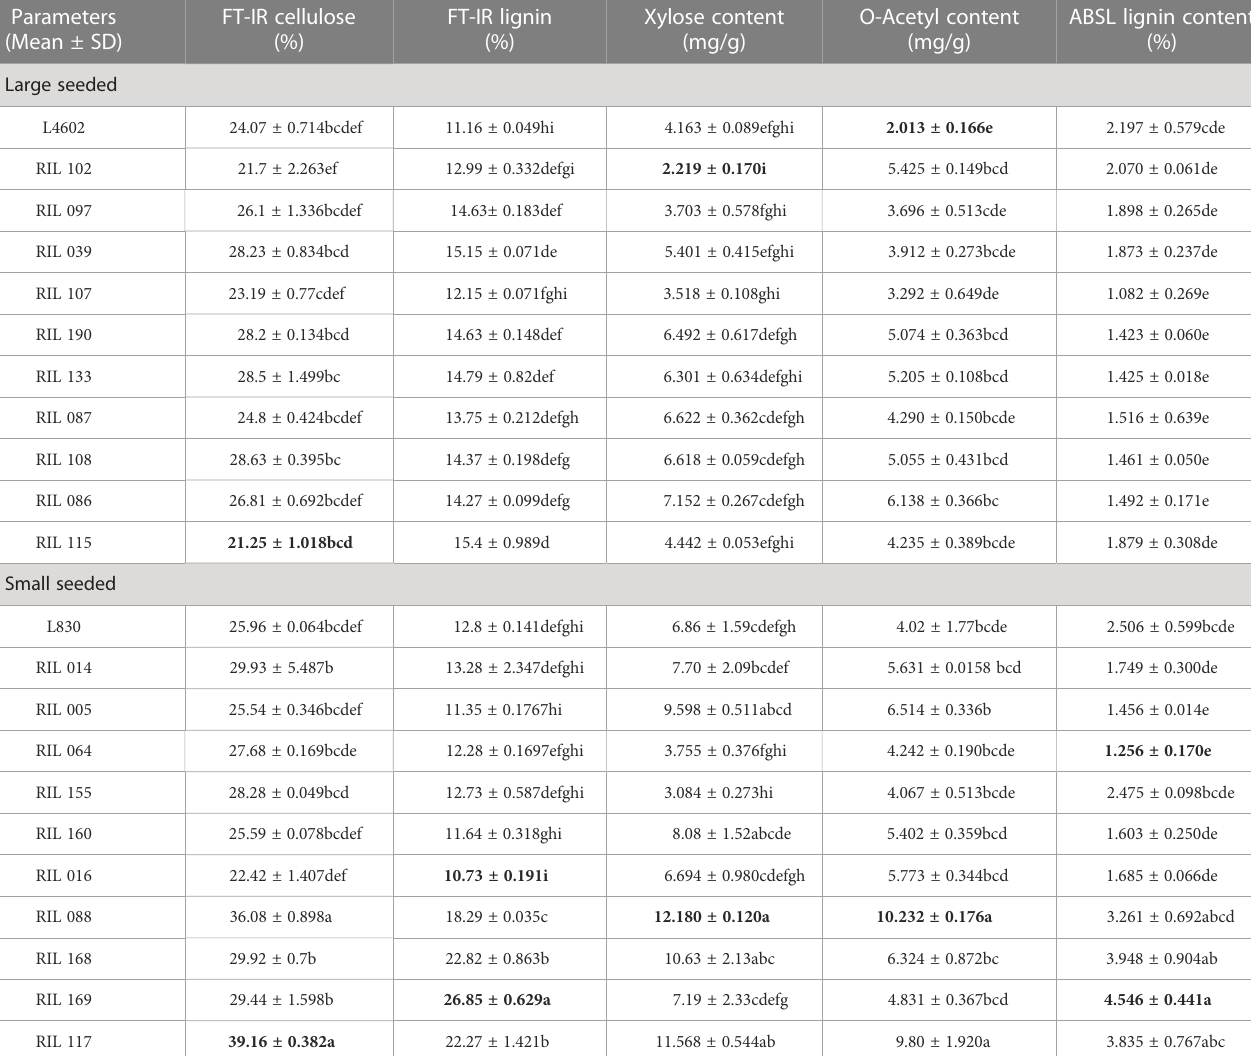
TABLE 3 Estimation of cellulose, lignin, acetyl bromide soluble lignin content (ABSL), D- xylose, and acetylated xylose in the mature lentil seeds of 20 RILs (including both parents) and multiple comparison test using Tukey HSD method. Parameters FT-IR cellulose (Mean ± SD)